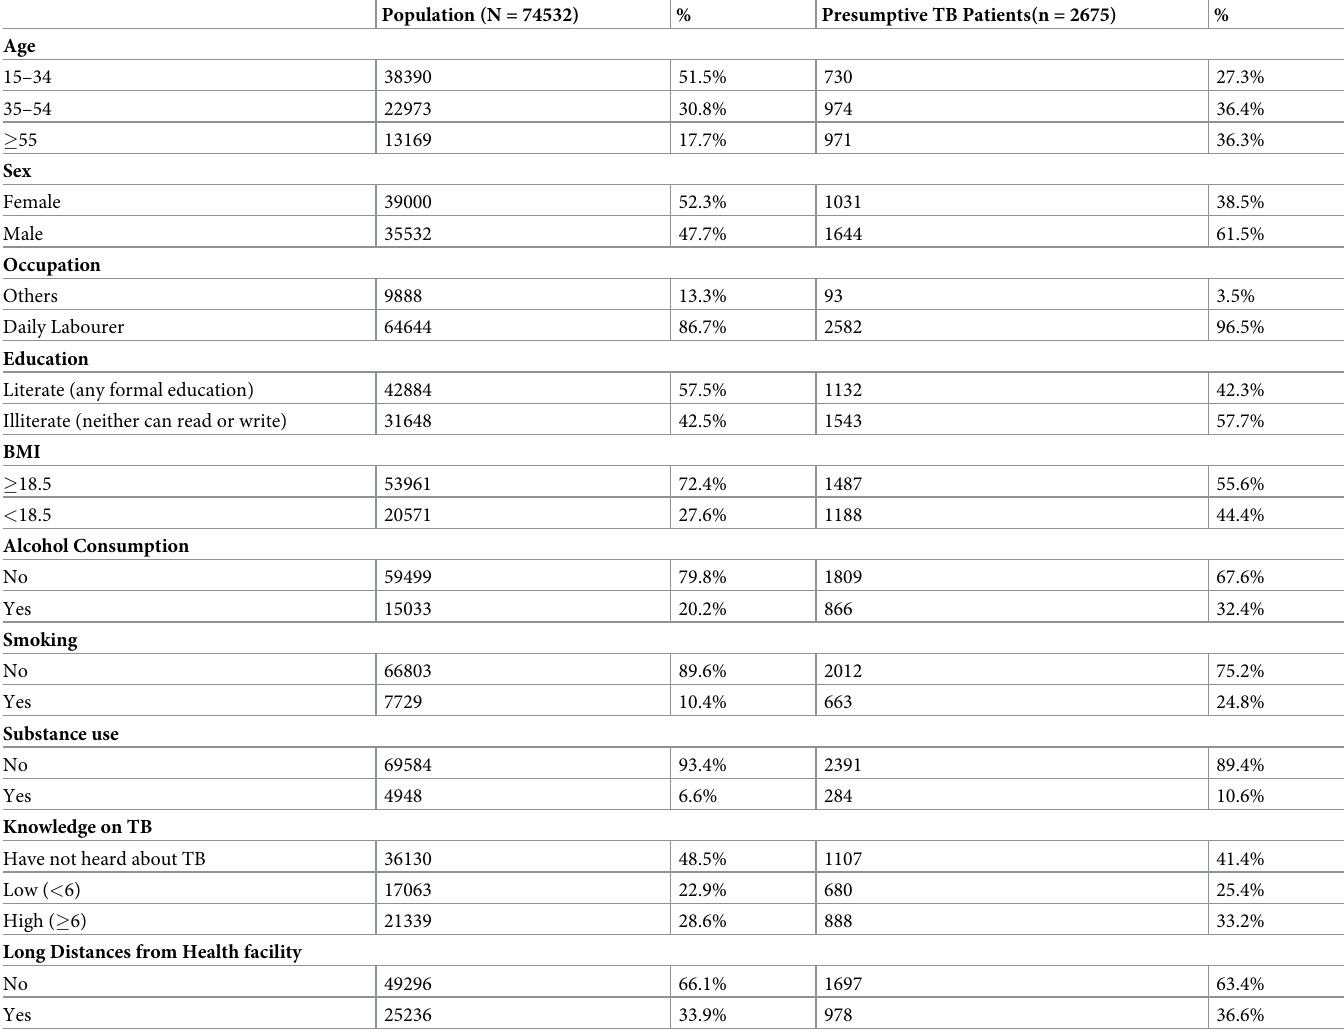
Table 1. Demographic details of the study population and the persons with presumptive